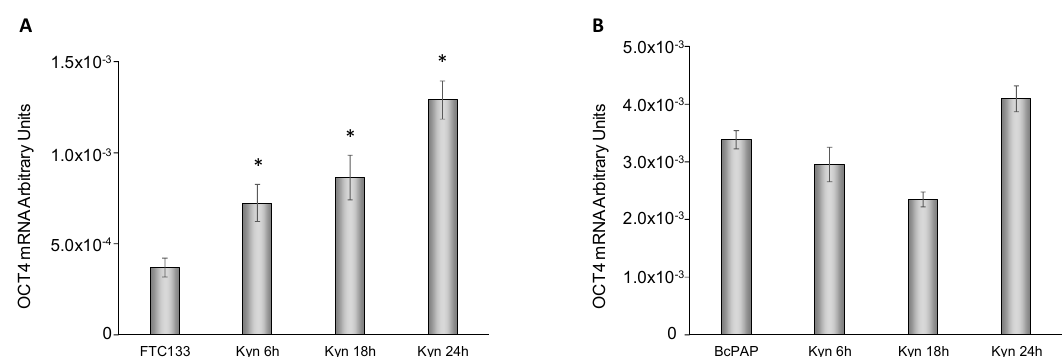
Figure 10. Kynurenine induced OCT4 gene. FTC-133 ( A ) and BcPap ( B ) cells were incubated for the indicated times with kynurenine (100 µM) and harvested for total RNA extraction and cDNA synthesis. OCT4 mRNA expression levels were assayed by qPCR. The data are presented as means of arbitrary units. All experiments were repeated three times, and the more representative results are depicted. Kyn: kynurenine treated cells. p values were calculated applying the unpaired Student’s t test. *, p < 0.05.